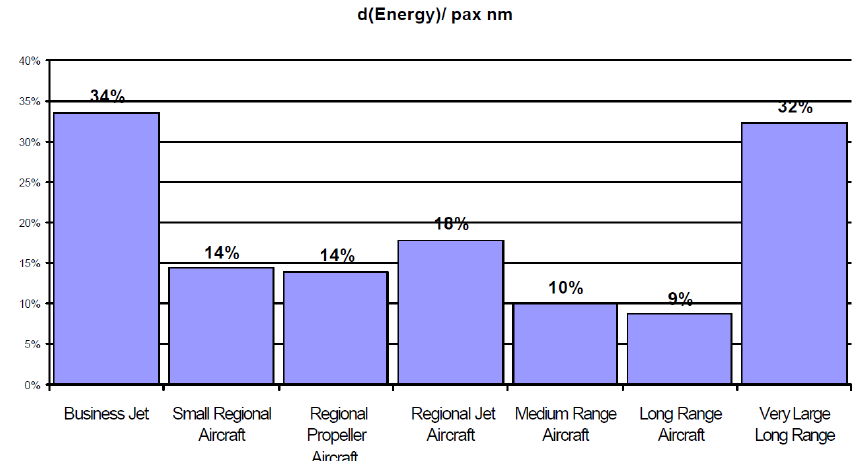
Figure 21. Change of energy consumption for H 2 -fueled aircrafts as compared to equivalent kerosene-fueled aircrafts [36]. Figure 20. Changes in the operating empty weight and maximum take-off weight for an LH 2 powered aircraft as compared to equivalent kerosene-fueled aircraft. [36].